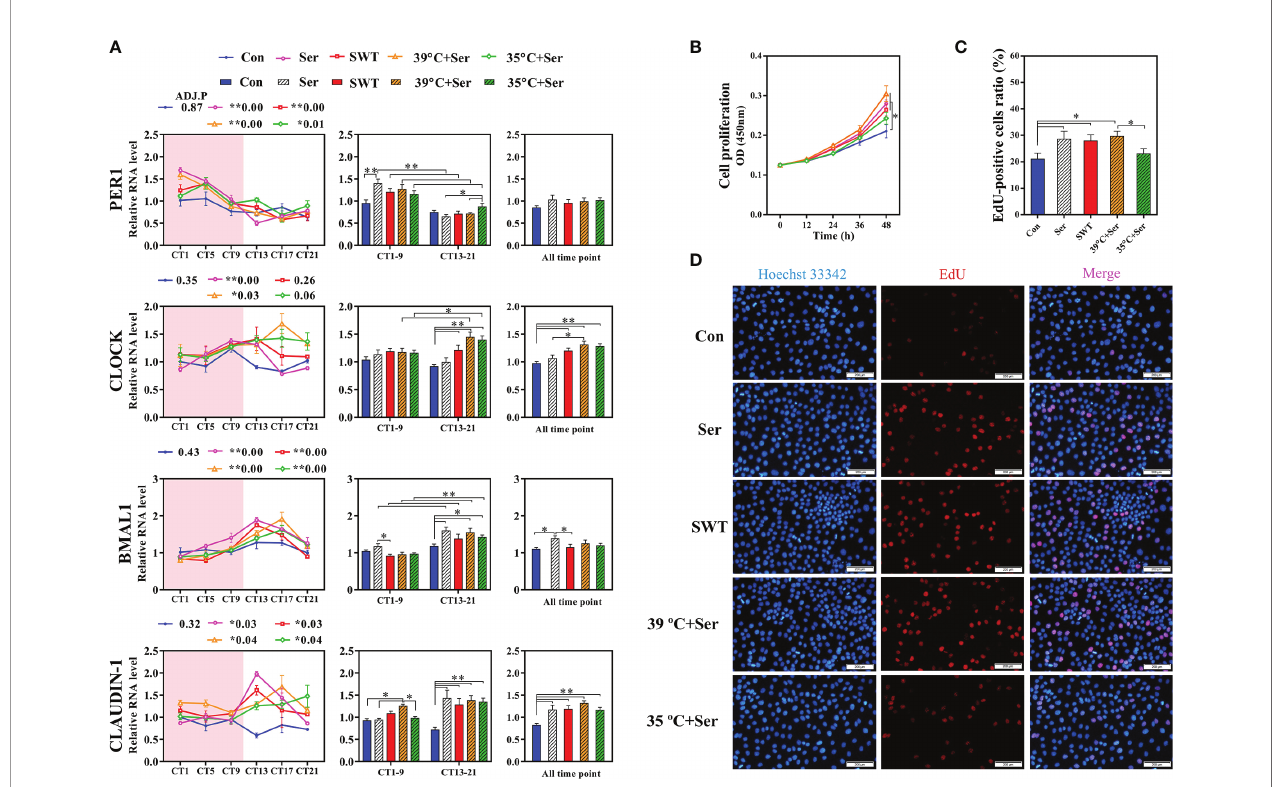
FIGURE 6 | Effects of serotonin and temperature diurnal oscillation on expression of clock and tight junction gene in rabbit intestinal epithelial cells (RIEC). (A) Effects of rhythmic addition of serotonin and square wave temperature on the expression of clock and Claudin-1 in RIEC. The control group (Control, Con); the 12 h rhythmically added serotonin group (Serotonin, Ser); the square wave temperature group (SWT); addition of serotonin at 39°C (39°C + Ser); addition of serotonin at 35°C (35°C + Ser). (B) Cell viability of RIEC. (C) The percentage EdU-positive RIECs and (D) RIEC proliferation using EdU staining. ADJ.P for adjusted minimal p - values, ADJ.P < 0.05 indicates signi fi cant diurnal rhythm, AMP represents amplitude, *ADJ.P < 0.05; **ADJ.P < 0.01. Differences between the groups were determined with a t-test. Data are shown as the mean ± SEM. * p < 0.05; ** p <